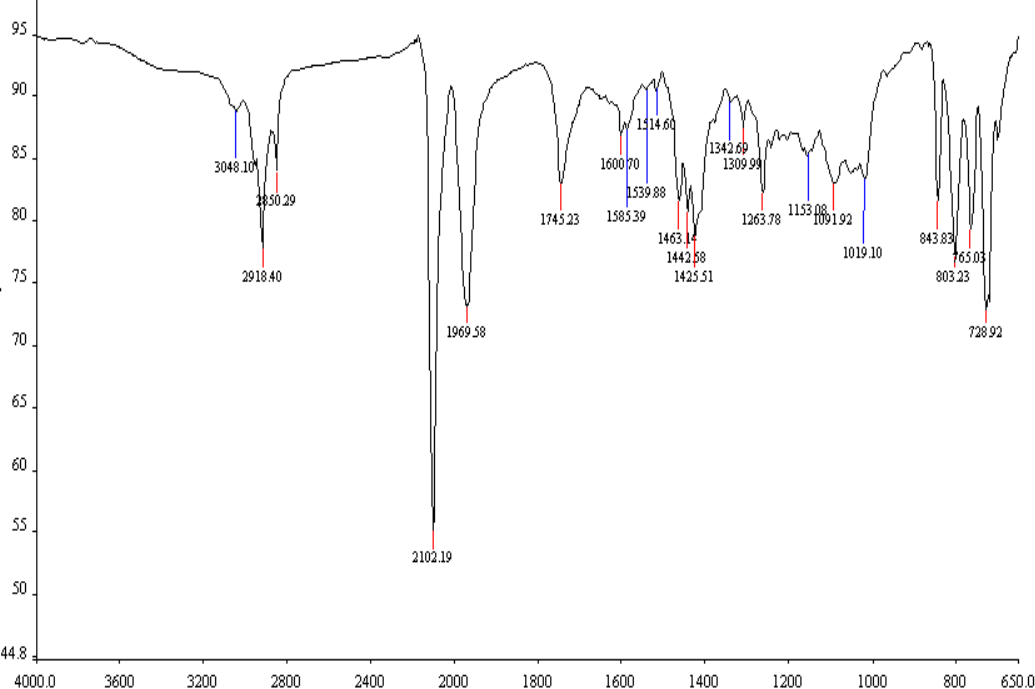
Figure 1. FT-IR spectrum of [RuL